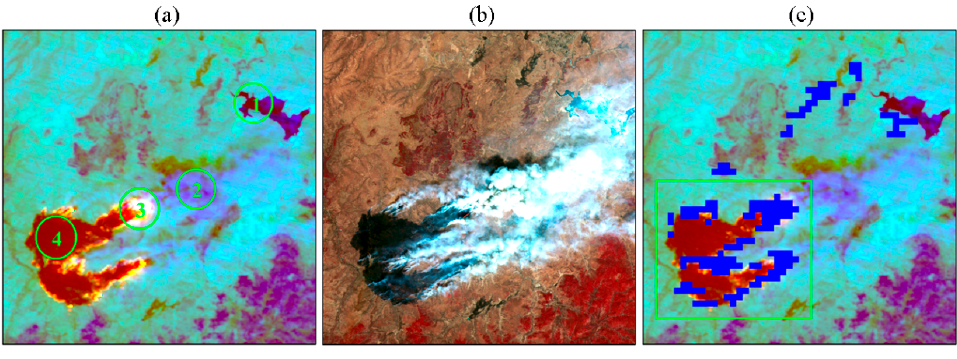
Figure 4. Reference images acquired on 29 April 2009: ( a ) HJ-1B IRS false color image (R: band 7, G: band 6, B: band 5), dark blue represents water (green circle 1), blue represents smoke (green circle 2), bright red represents active fire (green circle 3) and reddish brown represents post fire (green circle 4); ( b ) HJ-1B CCD false color image (R: band 4, G: band 3, B: band 2); and ( c ) MODIS fire product.